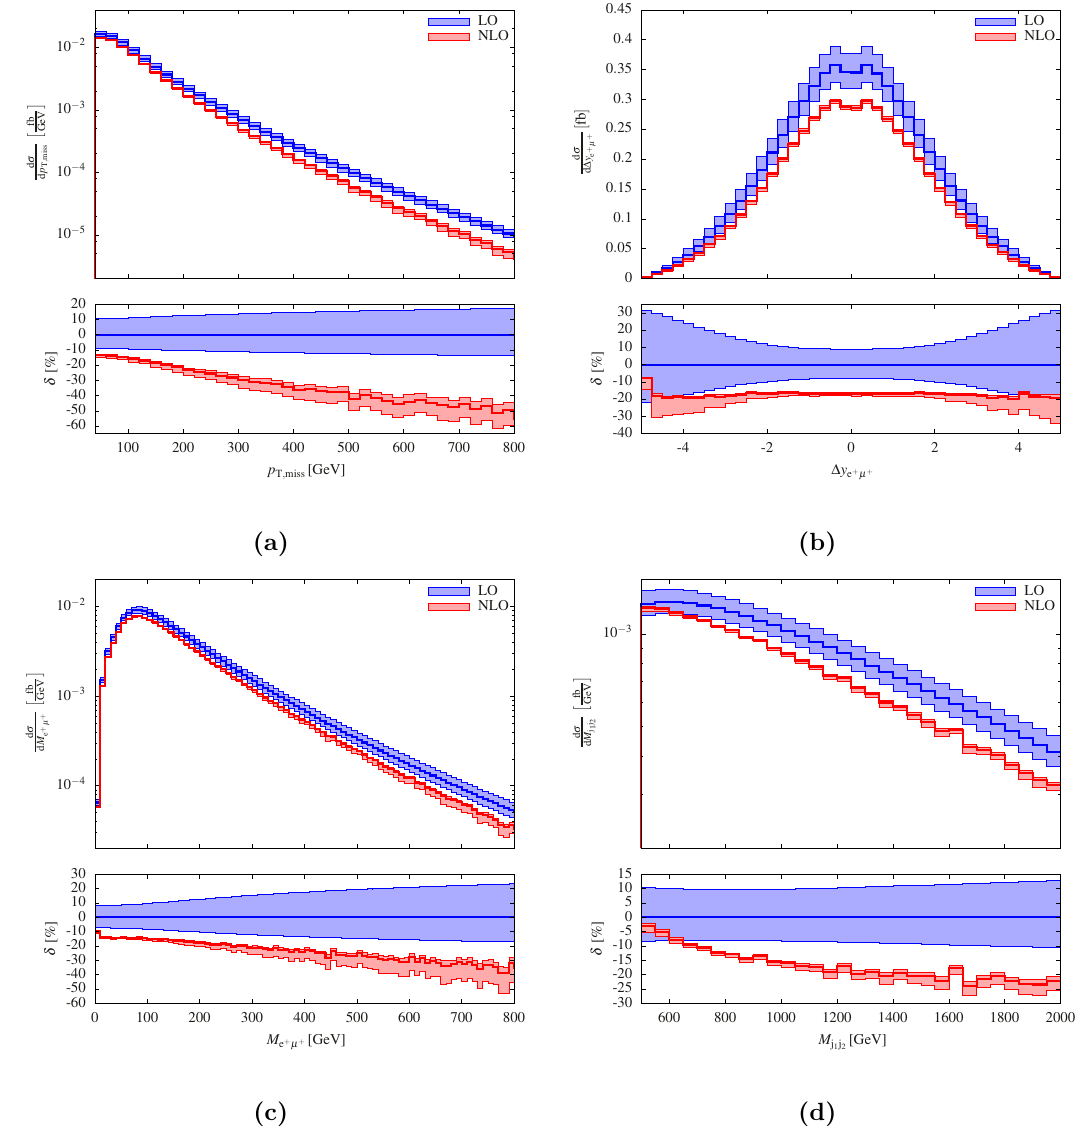
Figure 7. Di(cid:11)erential distributions at a centre-of-mass energy p s = 13 TeV at the LHC for pp (cid:22) + (cid:23) (cid:22) e + (cid:23) e jj: (a) missing transverse momentum (top left), (b) rapidity separation between the ! positron and anti-muon (top right), (c) invariant mass of the positron and anti-muon system (bottom left), (d) invariant mass of the two tagging jets (bottom right). The upper panels show the sum of all LO and NLO contributions with scale variation. The lower panels show the relative corrections in per cent.